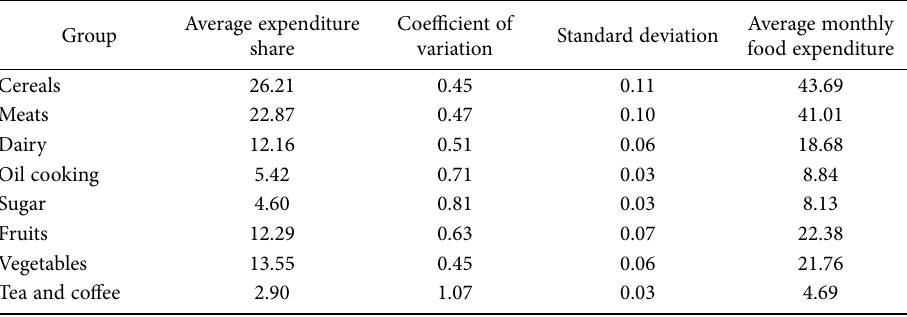
Table 1. Average expenditure shares of different food